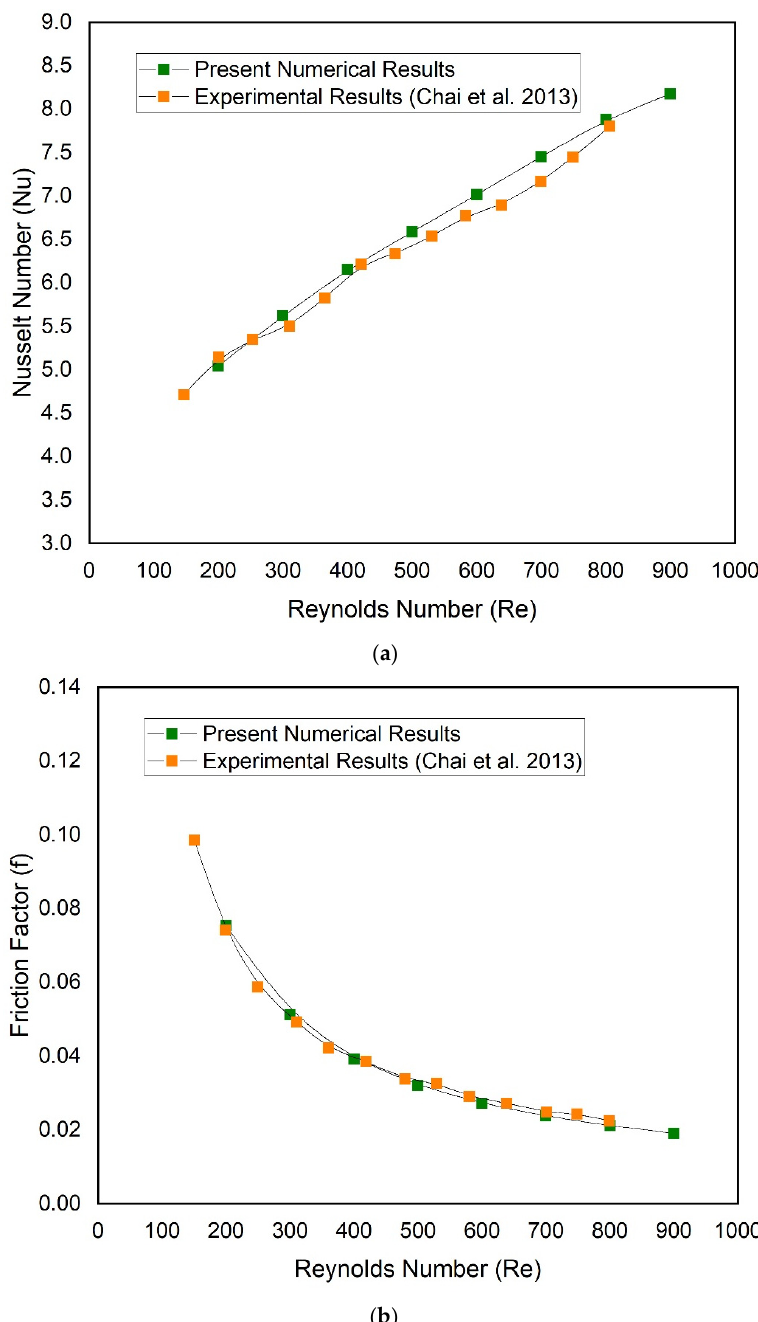
Figure 4. Comparison of numerical results with corresponding experimental [26]: ( a ) Nusselt number, ( b ) friction factor.